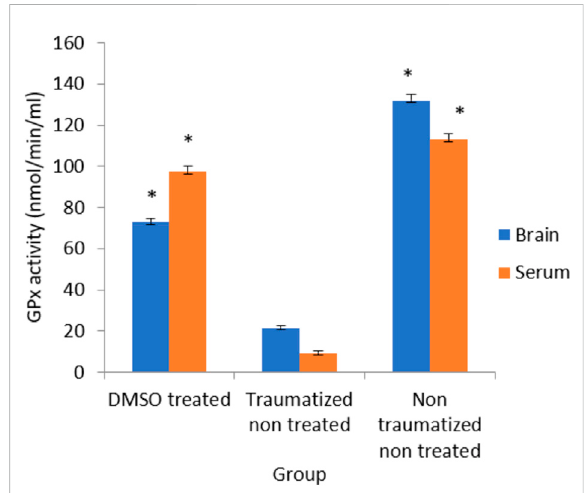
FIGURE 8 Effects of DMSO on the Activity of serum and brain cortex